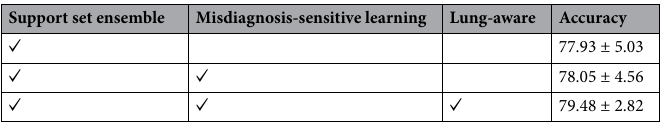
Table 4. Ablation studies.